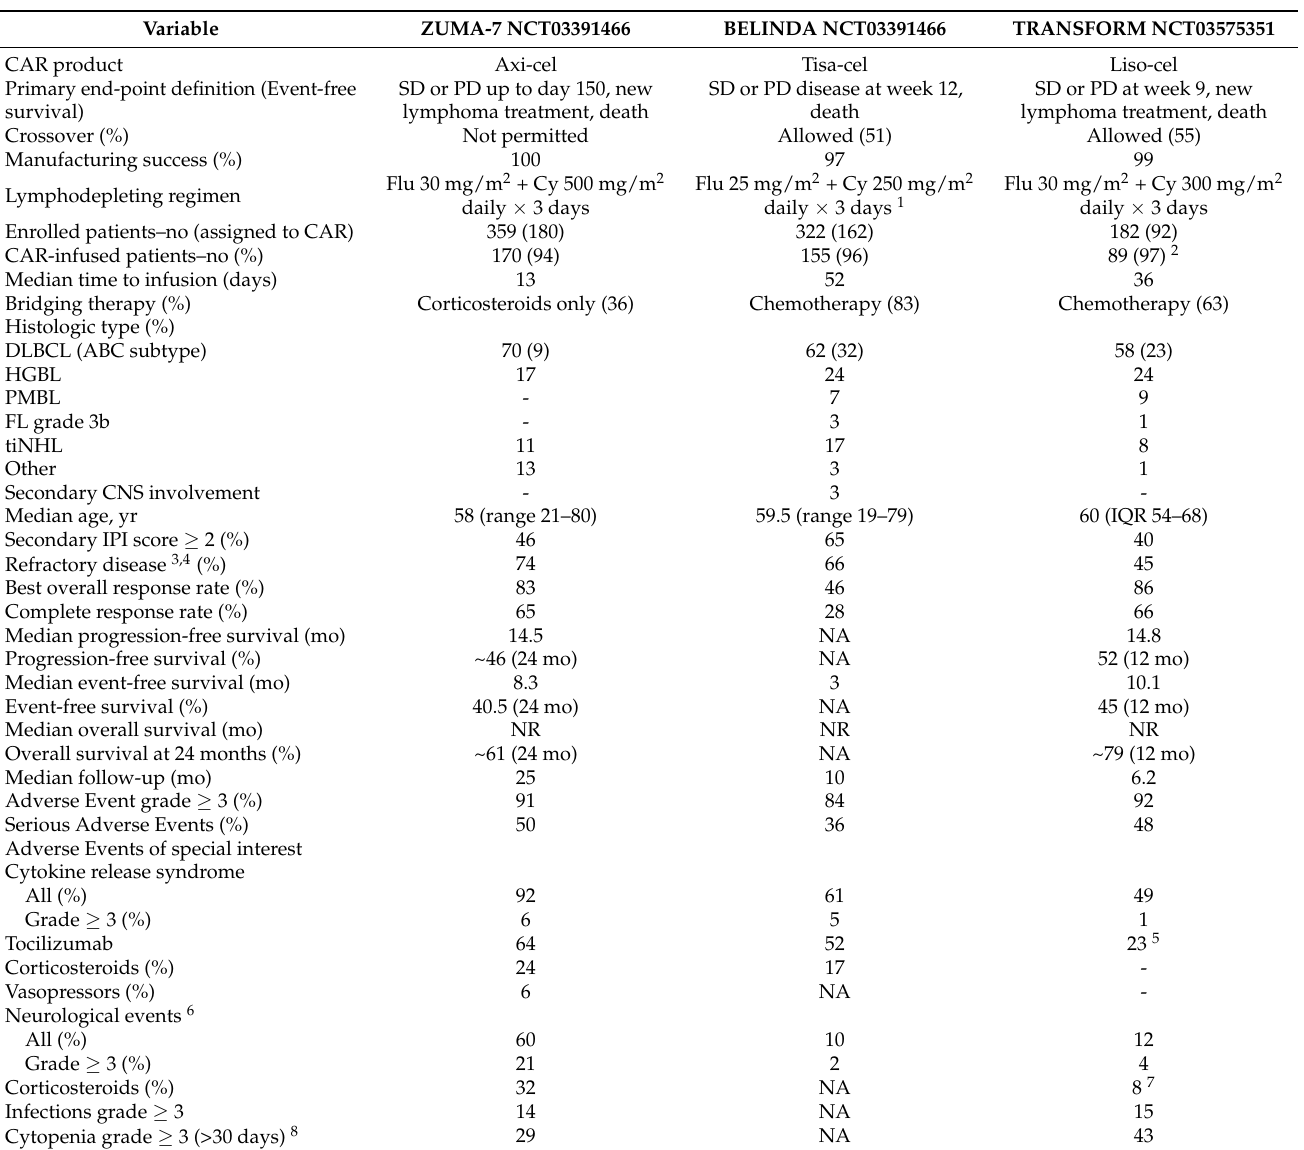
Table 3. Characteristics and results of CD19 auto-CAR arm in randomized phase 3 trials in re- lapse/refractory B cell lymphoma ≥ 1 line of